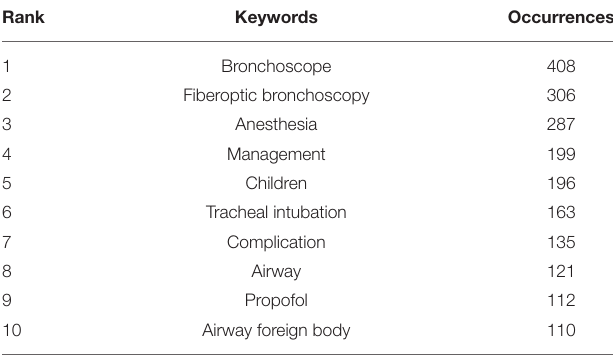
TABLE 3 | The top 10 most frequently used